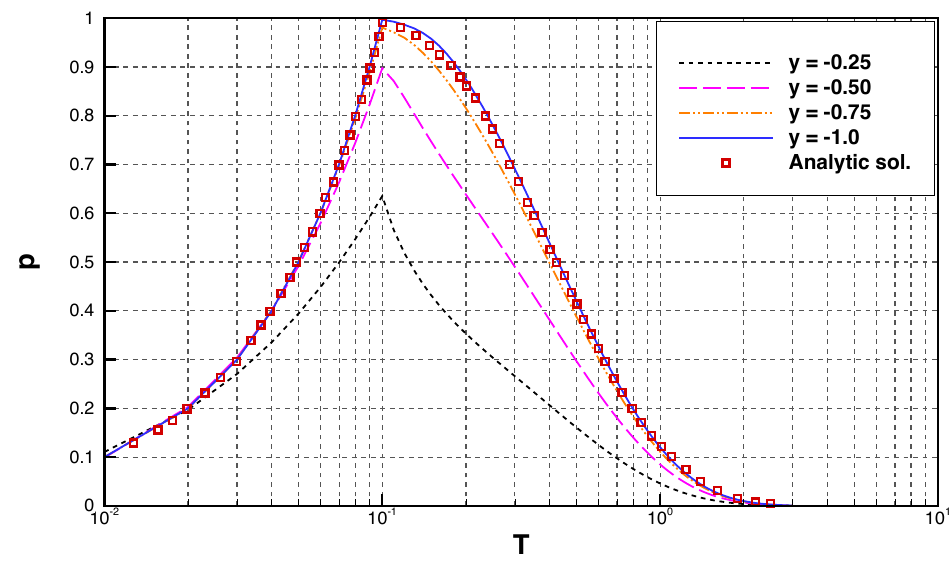
Figure 7. Results of the excess pore-water pressure in the one-dimensional consolidation